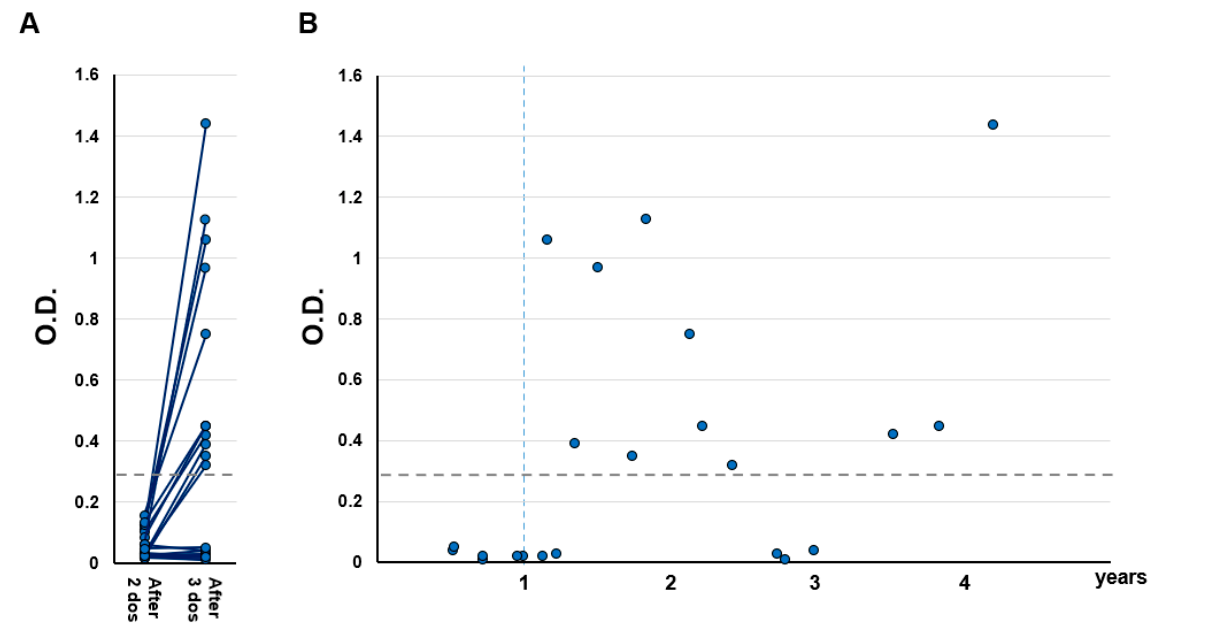
Figure 1. ( A ) Humoral quantitative anti-spike 1 (S1) antibody response 14 days (±7 days) after the second and third vaccination in B-cell lymphoma patients treated with anti-CD20 antibody (n = 22). The horizontal dotted line indicates the threshold (0.26) for seroconversion. ( B ) Relationship between S1 titer and time from the final dose of anti-CD20 antibody to the third dose of vaccination. The horizontal dotted line indicates the threshold (0.26) for seroconversion. O.D.: Optical density.